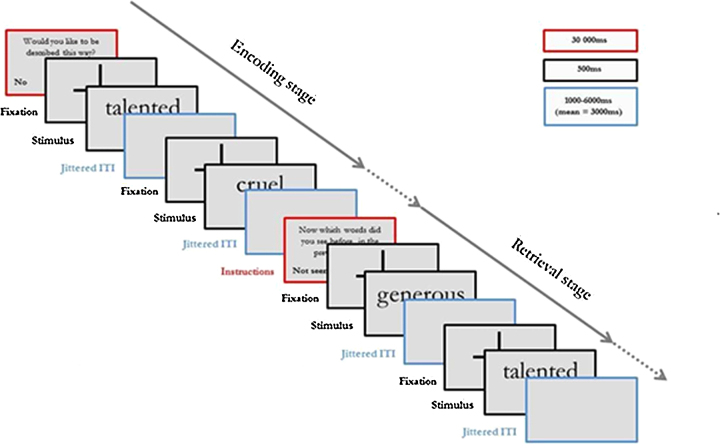
Schematic diagram of trial events in the encode/retrieve task. Boxes are labelled by stage, and box outline indicates duration: red = 30 s, black = 500 ms and blue is a jittered ITI with a mean of 3000 ms (range 1000–6000 ms), events depicted here, in order: encoding instructions, positive categorisation, negative categorisation, retrieval instructions, positive new word recognition (distractor: possible outcomes are correct rejection and false alarm), positive old word recognition (target: possible outcomes are hit and miss). Timeline indicates direction of progression, dashed line indicates where task continues but is not detailed in the diagram. In the retrieval stage, event types not shown are negative new word and negative old word. (For interpretation of the references to color in figure legend, the reader is referred to the web version of the article.)